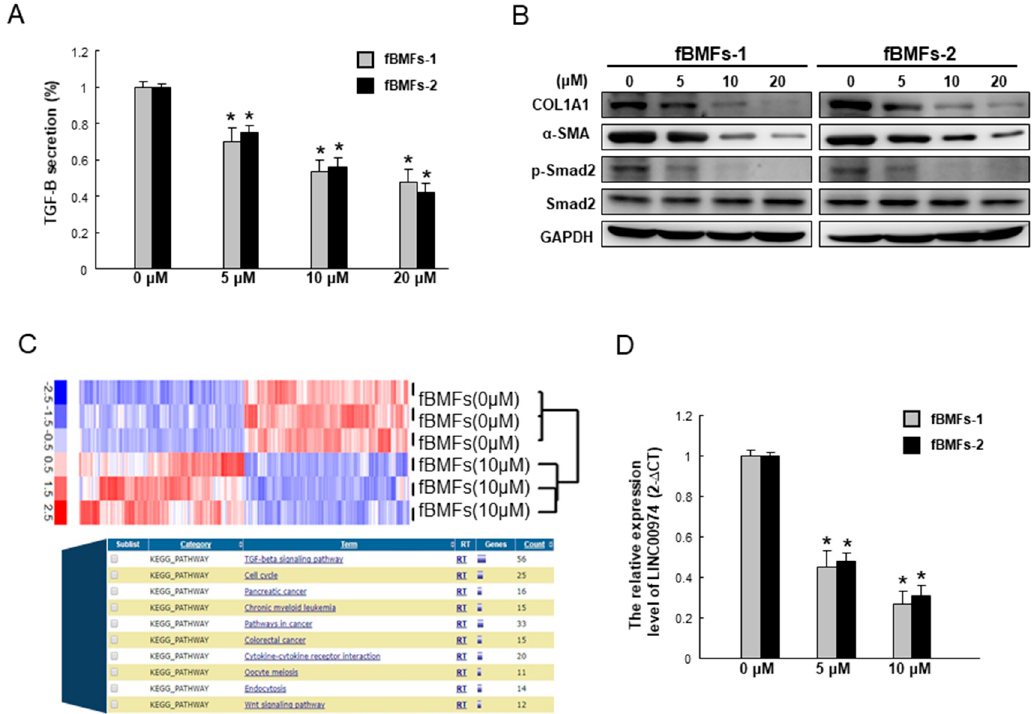
Figure 6. Arctigenin represses the expression of myofibroblast markers and the TGF- β /Smad2 signaling of fBMFs by targeting LINC00974. ( A ) Arctigenin dose-dependently downregulated the secretion of TGF- β 1 in two fBMFs; ( B ) The protein expression levels of myofibroblast markers, including COL1A1 and α -SMA, as well as phosphor-Smad2 were reduced after arctigenin treatment in a dose-dependent manner; ( C ) The indicated lncRNAs’ expression levels in the arctigenin-treated fBMFs were analyzed by a high-throughput RNA sequencing approach and bioinformatics analysis; ( D ) qPCR analysis was applied to analyze the relative LINC00974 expression level in arctigenin-treated fBMFs. * p < 0.05 as compared with the non-arctigenin-treated group.